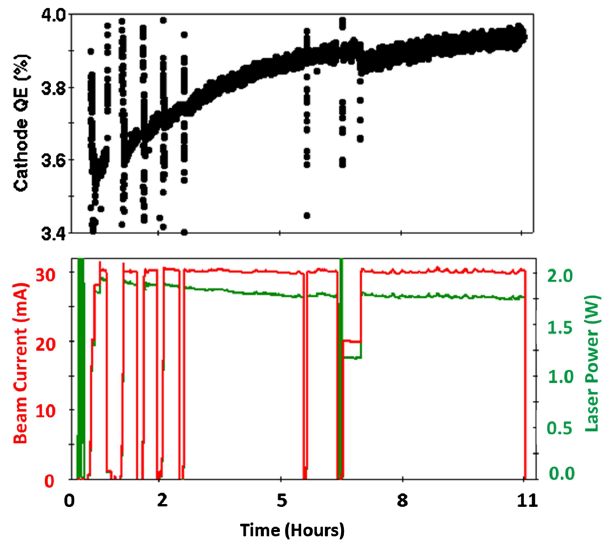
FIG. 10. High-current 9 MHz CWoperation (up to 30 mA) with laser beam intensity feedback. Top: Cathode QE (black). Bottom: Average laser power delivered to the cathode (green) and beam current measured by the DCCT (red).